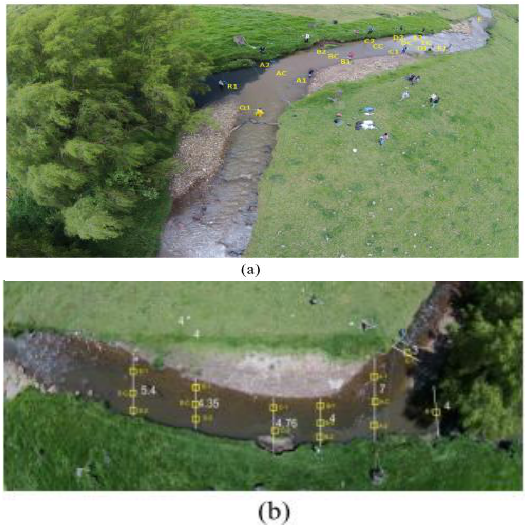
Figure 1 Identification of sample points. (a) Photograph from campaign No. 1. (b) Photograph from the field trip.